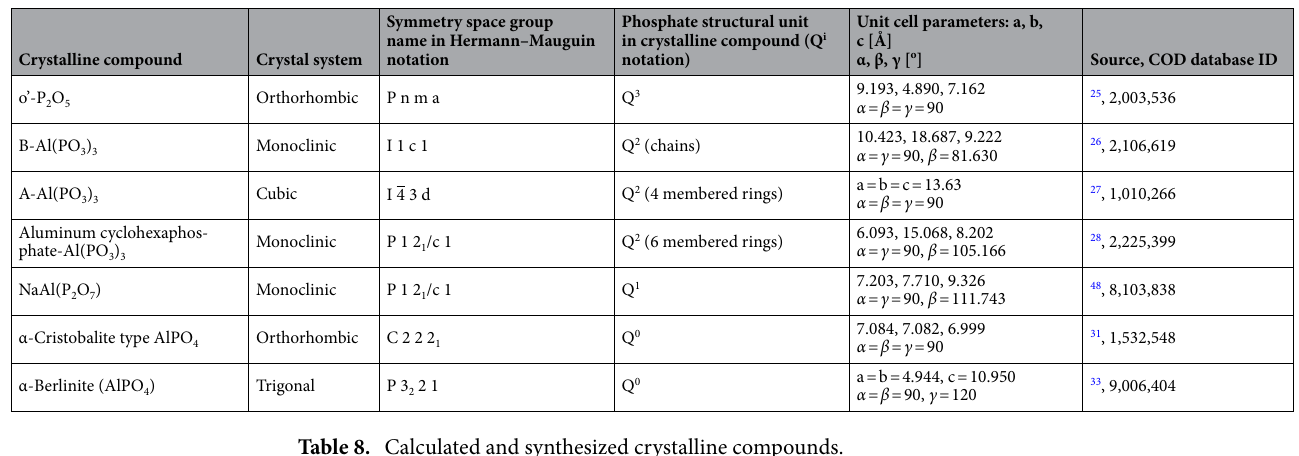
Table 8. Calculated and synthesized crystalline compounds.